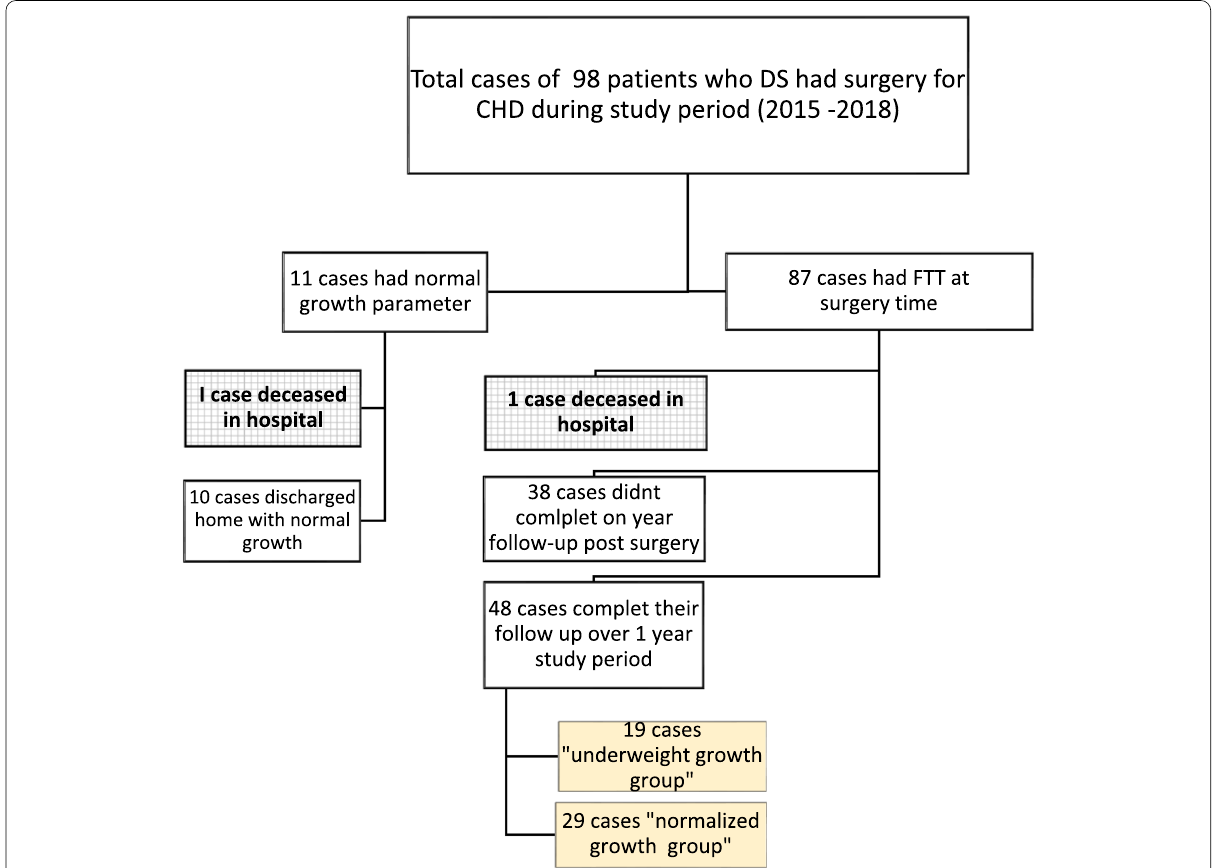
Fig. 1 Distribution of cases of Down syndrome who underwent cardiac